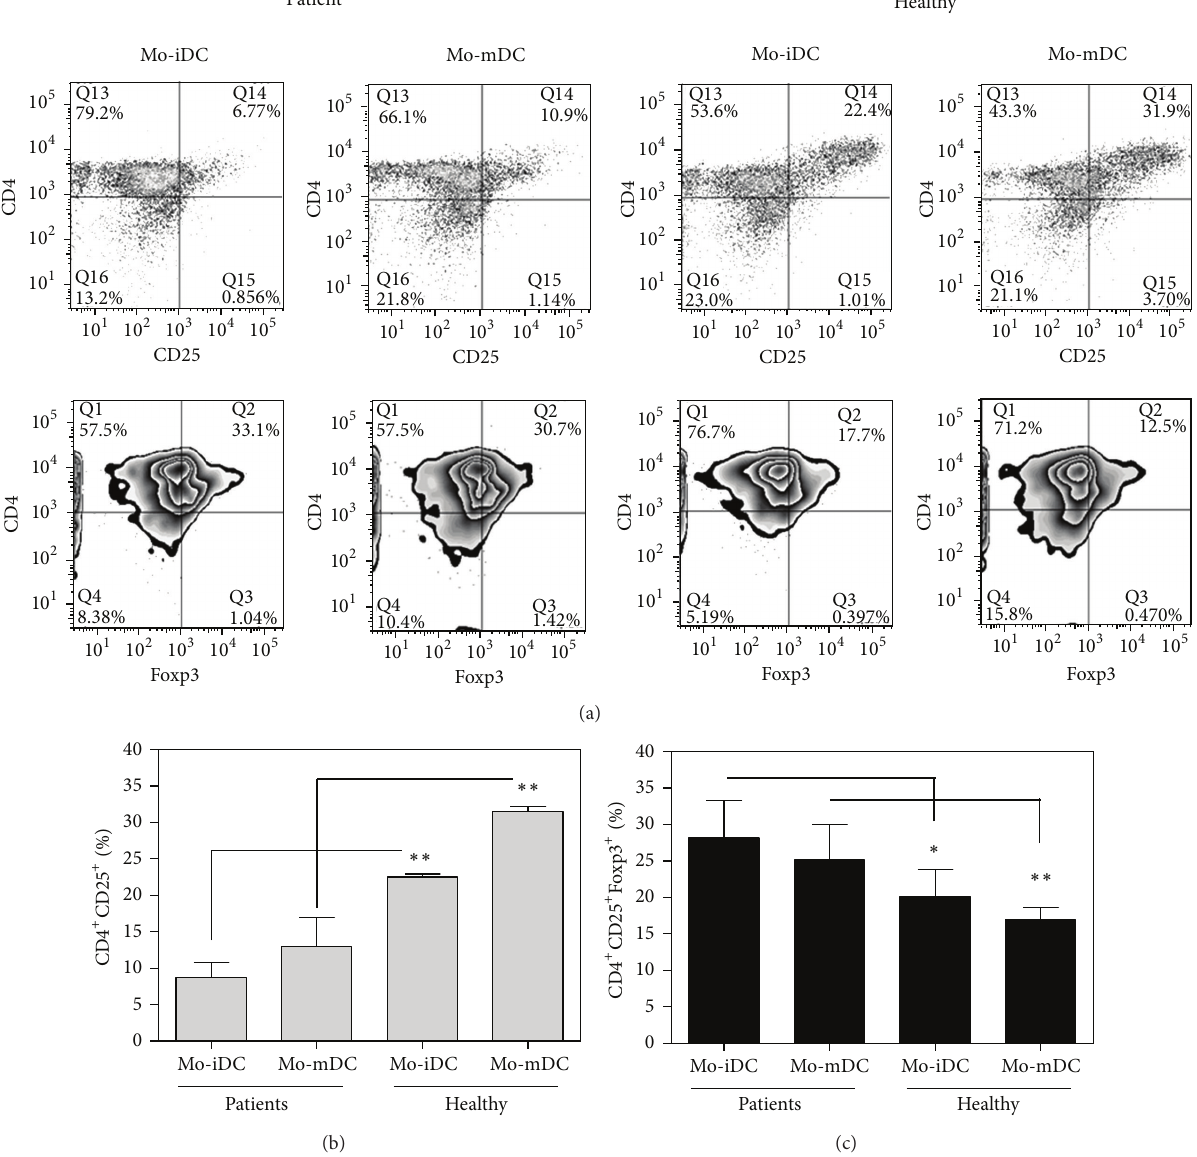
Figure 2: Patients’ Mo-DCs fail to activate CD 4 + lymphocytes and induce higher Foxp3 expression even after maturation. Mo-DCs from controls and breast cancer patients were cocultured with allogeneic CD 4 + CD45RA + cells for five days. At the end of culture the phenotype of lymphocytes was evaluated by flow cytometry. (a) Representative experiments of CD25 and Foxp3 expression in CD 4 + lymphocytes stimulated by immature DCs (Mo-iDCs) or mature DCs (Mo-mDCs) from healthy donors or breast cancer patients. Average frequency of CD2 5 + cells (b) and CD 4 + CD2 5 + Foxp 3 + cells (c) after CD 4 + CD45RA + lymphocytes’ coculture with Mo-DCs ( ∗ 𝑃 < 0.05 ; ∗∗ 𝑃 < 0.01 , two-tailed unpaired t- test; 𝑛 = 4 ). (Mature Mo-DCs were activated by TNF-alfa for 48